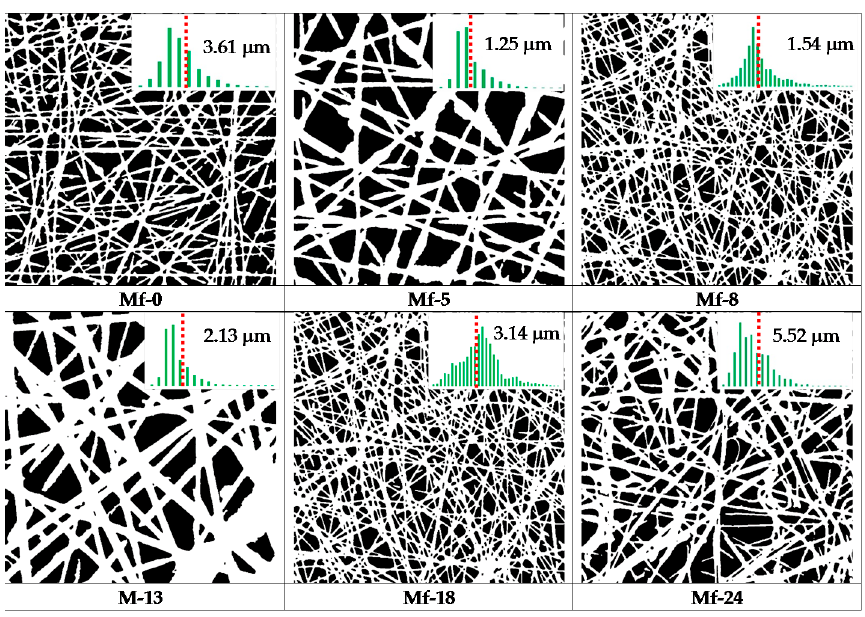
Figure 2. Determination of microfibre diameters by image digital analysis.